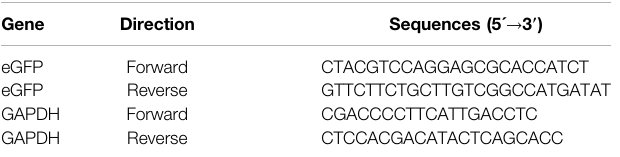
TABLE 1 | Sequences of the primers for quantitative real-time